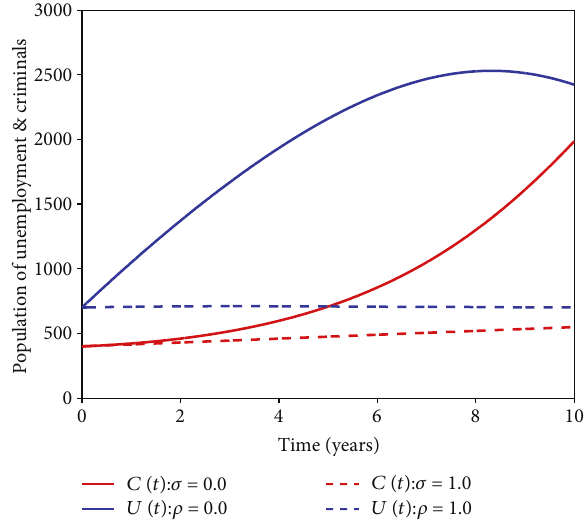
Figure 7: Simulation result showing the population of unemployment U ð t Þ and crime C ð t Þ